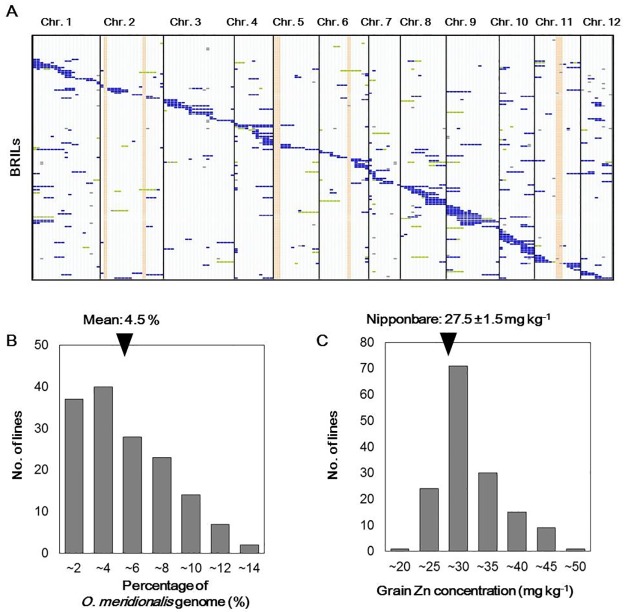
Genome coverage of backcross recombinant inbred lines (BRILs) and their grain Zn concentrations.(A) Graphical genotypes of 151 BRILs at BC2F7 between O. meridionalis W1627 and O. sativa ‘Nipponbare’ based on the 164 SSR loci. The chromosomal segments are indicated by colour: ‘Nipponbare’ homozygous (white), heterozygous (green), W1627 homozygous (blue), and unknown regions (grey). Chromosomal gaps not covered with W1627 homozygous segments of BRILs are shown in salmon. (B) Frequency distribution of the percentage of the O. meridionalis W1627 genomes found in the BRILs. (C) Frequency distribution of grain Zn concentration in the BRILs. The average grain Zn concentration of O. sativa ‘Nipponbare’ is shown.